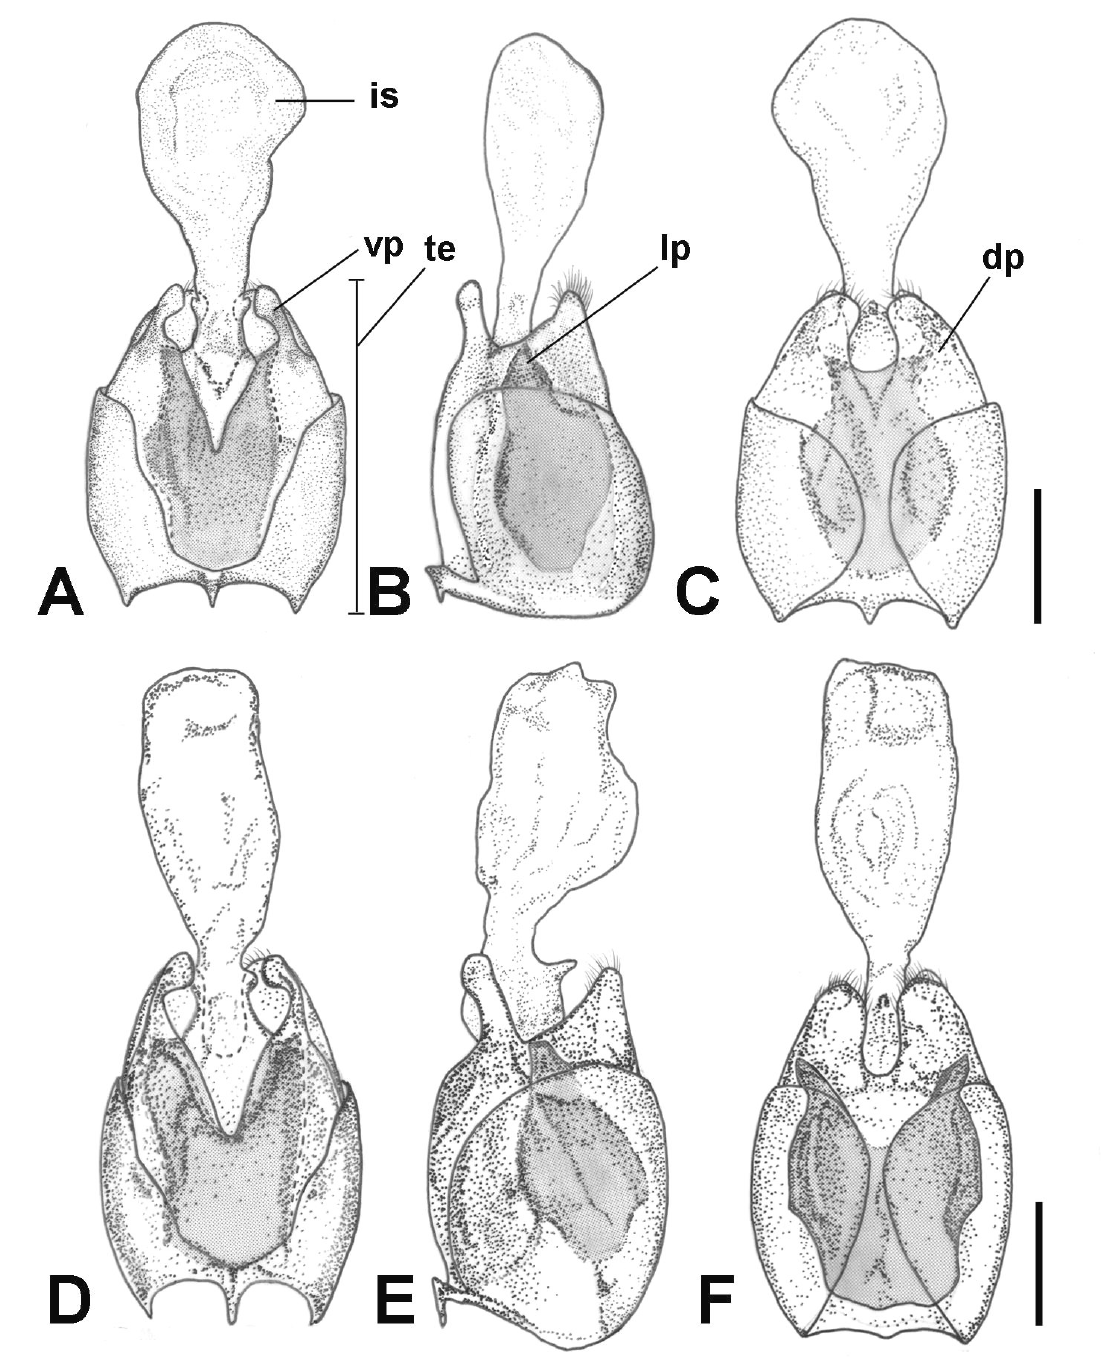
Fig. 3. Aedeagus. A–C . Lycocerus pictus (Wittmer, 1983). D–F . L. yitingi Hsiao & Okushima sp. nov. A, D. Ventral view. B, E. Lateral view. C, F. Dorsal view. Scale bars: 0.5